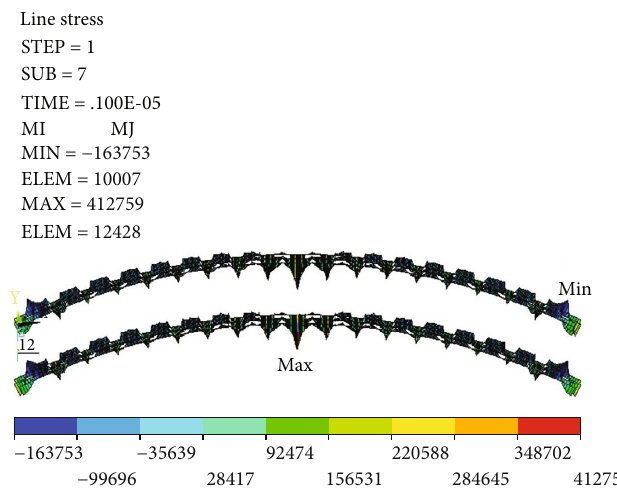
Figure 2: The axial force cloud map of main arch under case 5 (N).